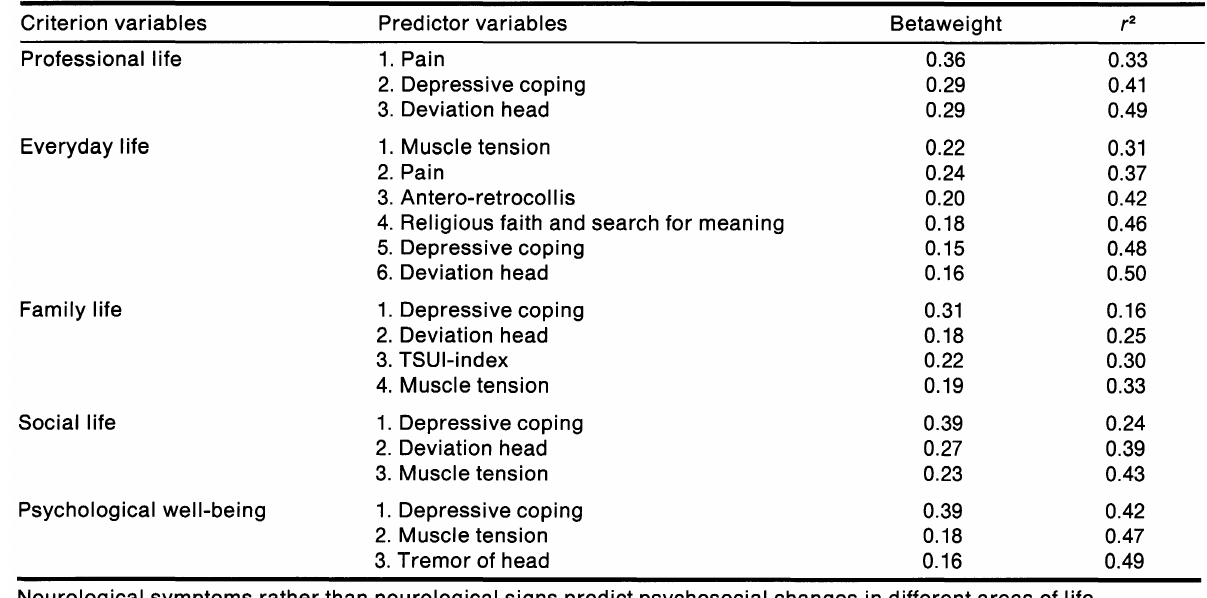
TABLE III. Multiple regression analysis with psychosocial changes (scales of the FOD) as dependant variables Criterion